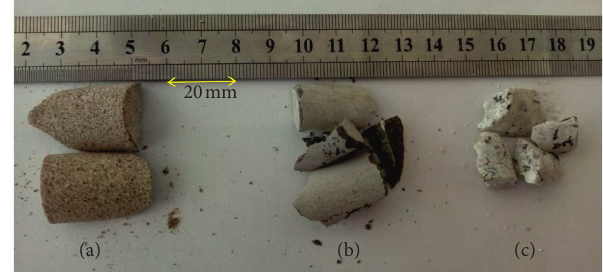
Figure 8: Debris of core columns under static-pressure breaking: (a) sandstone; (b) limestone; (c) granite.